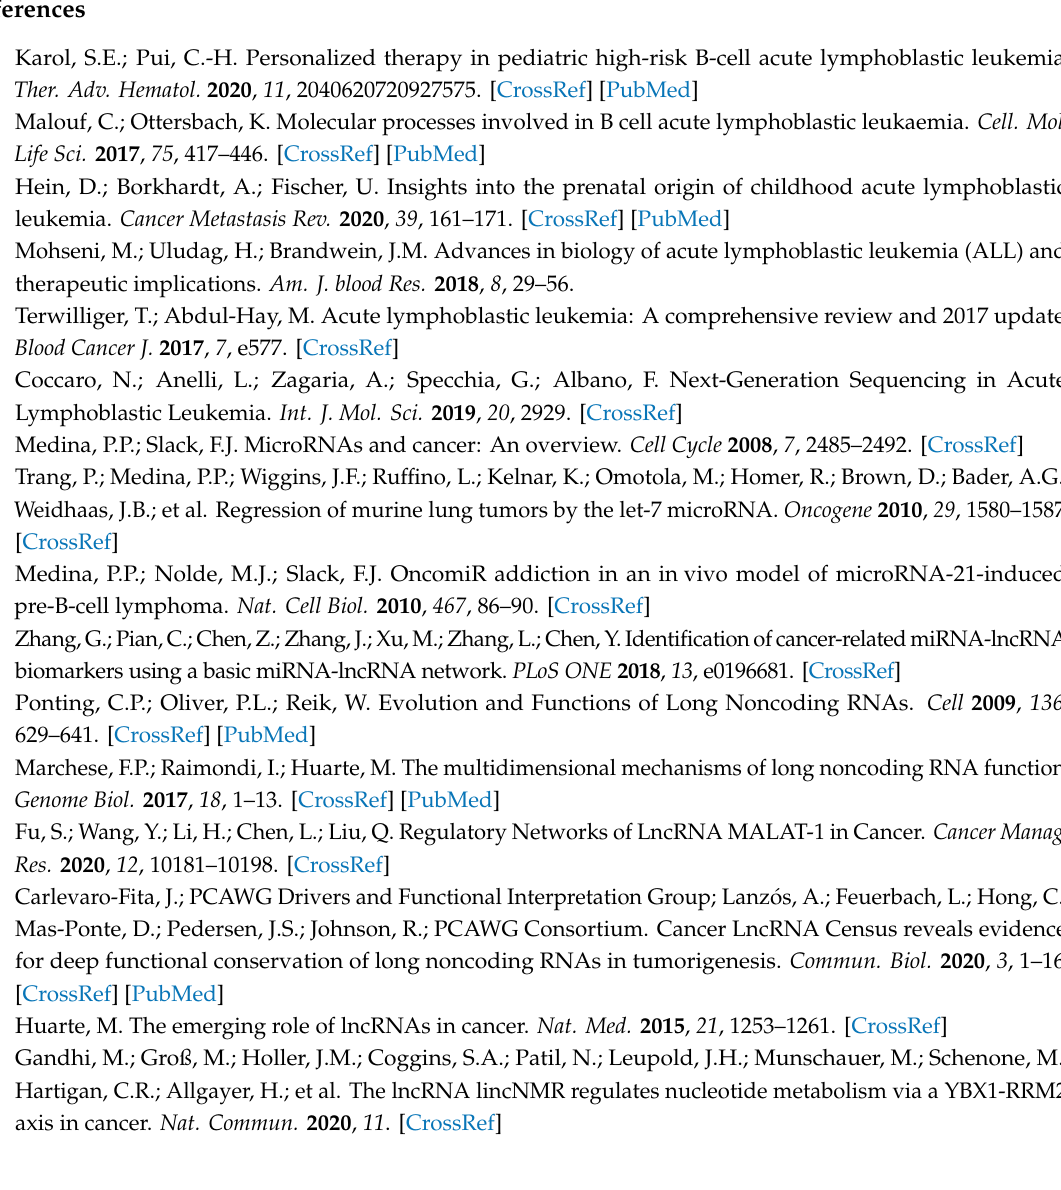
Figure A6. Kaplan-Meier overall survival curves of pediatric T-ALL patients divided in two groups Figure A6. Kaplan ‐ Meier overall survival curves of pediatric T ‐ ALL patients divided in two groups according to whether AL133346.1 ( a ) and CCN2 ( b ) expression was non-null or null: “AL133346.1 according to whether AL133346.1 ( a ) and CCN2 ( b ) expression was non ‐ null or null: “AL133346.1 high”, “AL133346.1 low”, “CCN2 high” and “CCN2 low”. The p-values of Cox univariate analysis high”, “AL133346.1 low”, “CCN2 high” and “CCN2 low”. The p ‐ values of Cox univariate analysis are are shown.